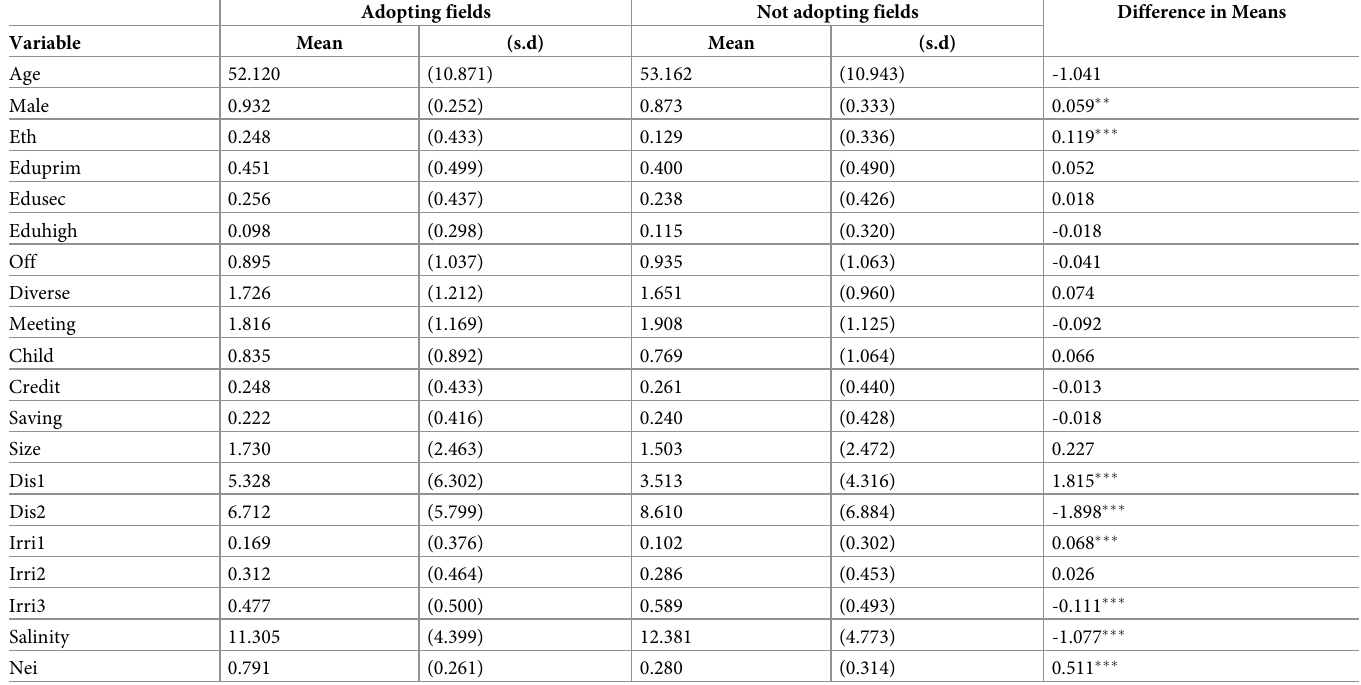
Table 5. Descriptive statistics for fields adopting and not adopting CURE-related varieties, 2018 He Thu season. Adopting